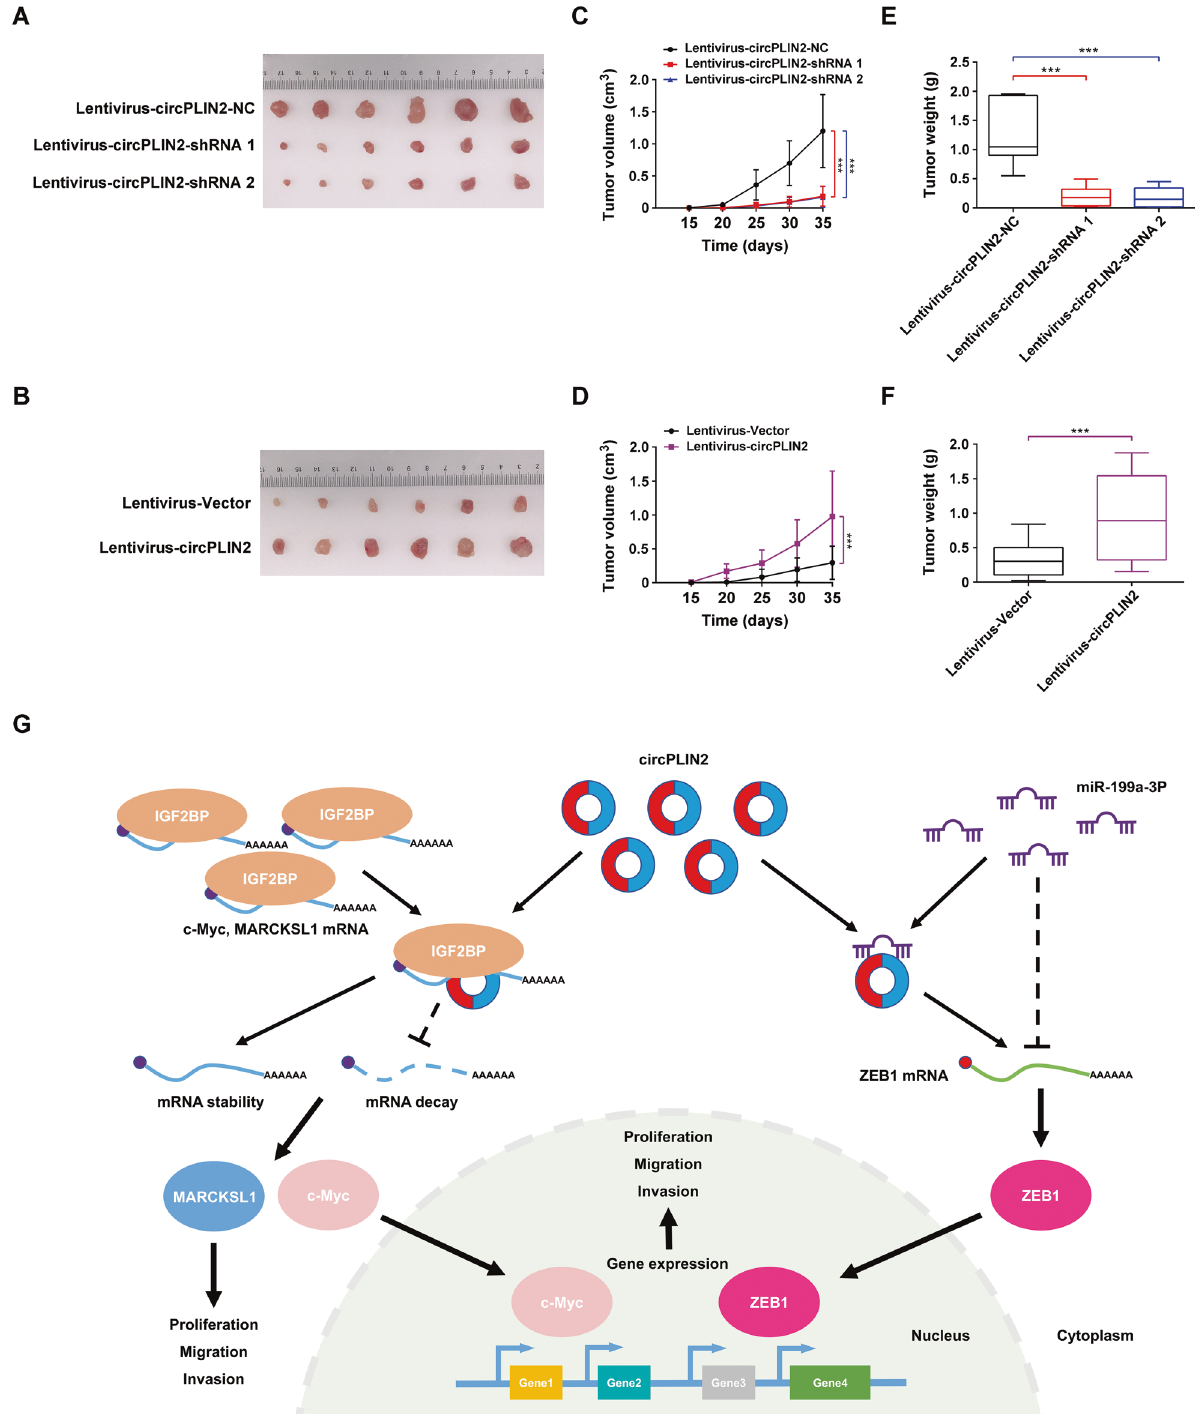
Fig. 8 circPLIN2 promotes ccRCC tumor growth in vivo. A Following subcutaneous injections of ACHN cells transfected with lentivirus- circPLIN2-shRNA 1/2 or lentivirus-circPLIN2-NC in athymic nude mice and after monitoring tumor growth for 35 days, photographs of the tumors were obtained at necropsy. B Following subcutaneous injections of ACHN cells transfected with lentivirus-circPLIN2 or lentivirus-vector in athymic nude mice and after monitoring tumor growth for 35 days, photographs of the tumors were obtained at necropsy. C , D The volumes of subcutaneous xenograft tumors of ACHN cells were measured every 5 days. E , F Boxplot showing the weights of xenograft tumors established using ACHN cells that were isolated from nude mice 35 days after subcutaneous injection. G Hypothesis diagram illustrating the function and mechanism of circPLIN2 in ccRCC progression. Two-tailed Student ’ s t test. The error bars represent S.D. *** p < 0.001.